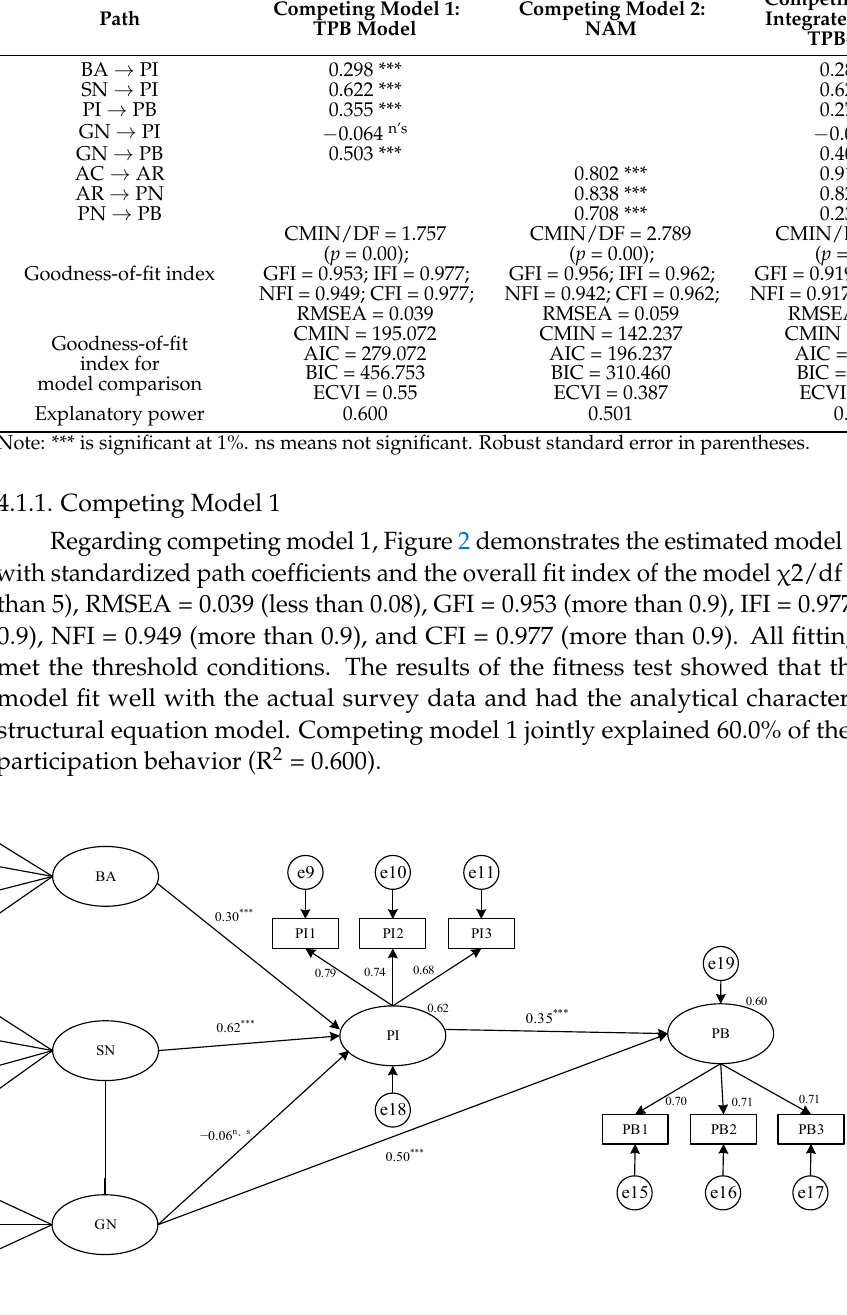
Figure 2. Competing model 1: TPB model. Note: *** is significant at 1%. ns means not significant. Robust standard error in